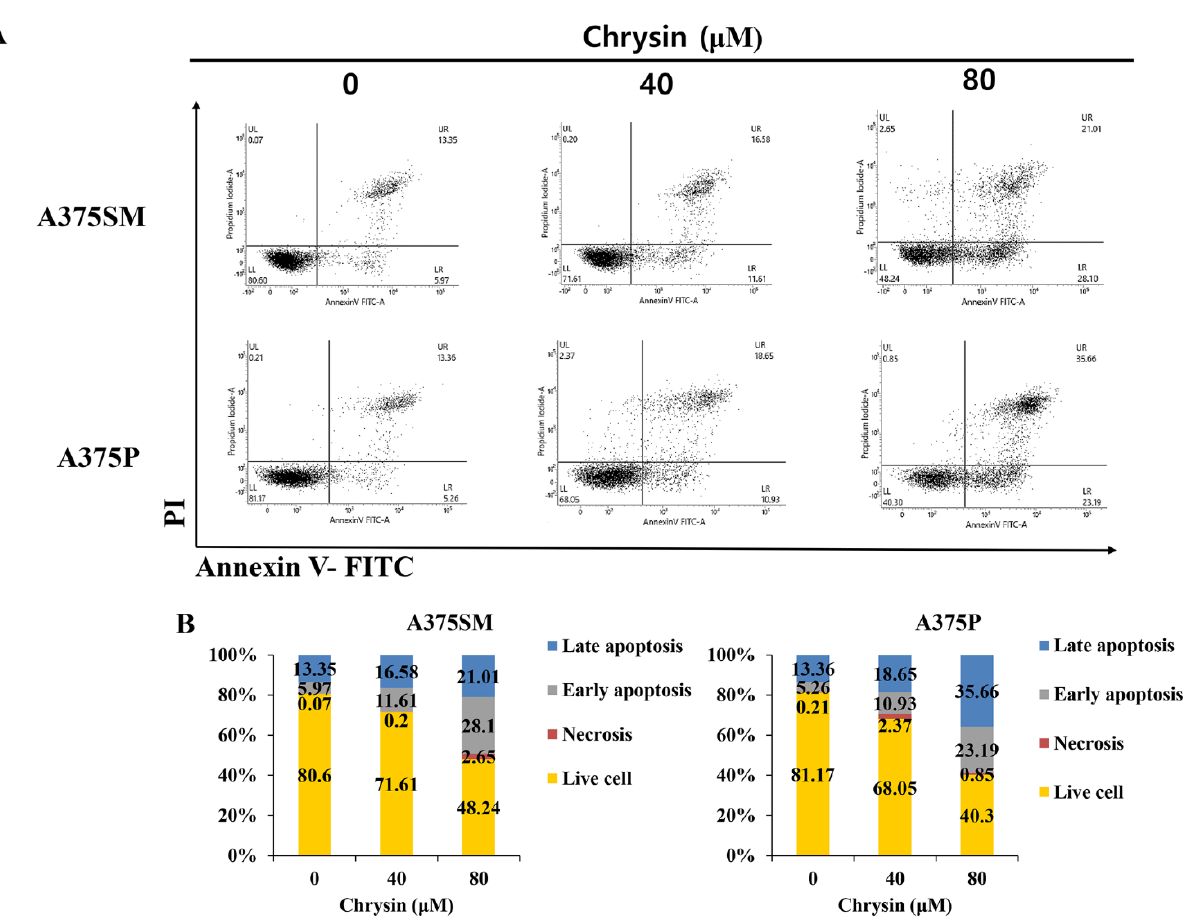
Figure 3. Chrysin induces apoptosis in A375SM and A375P human melanoma cancer cells. ( A ) Cells were seeded for 24 h. After treatment with the indicated concentrations of chrysin for 24 h, cells were harvested, stained with annexin V − propidium iodide, and analyzed by flow cytometry for apoptosis rates. ( B ) Graphs represent the percentages of living cells, necrotic cells, and early and late apoptotic cells.